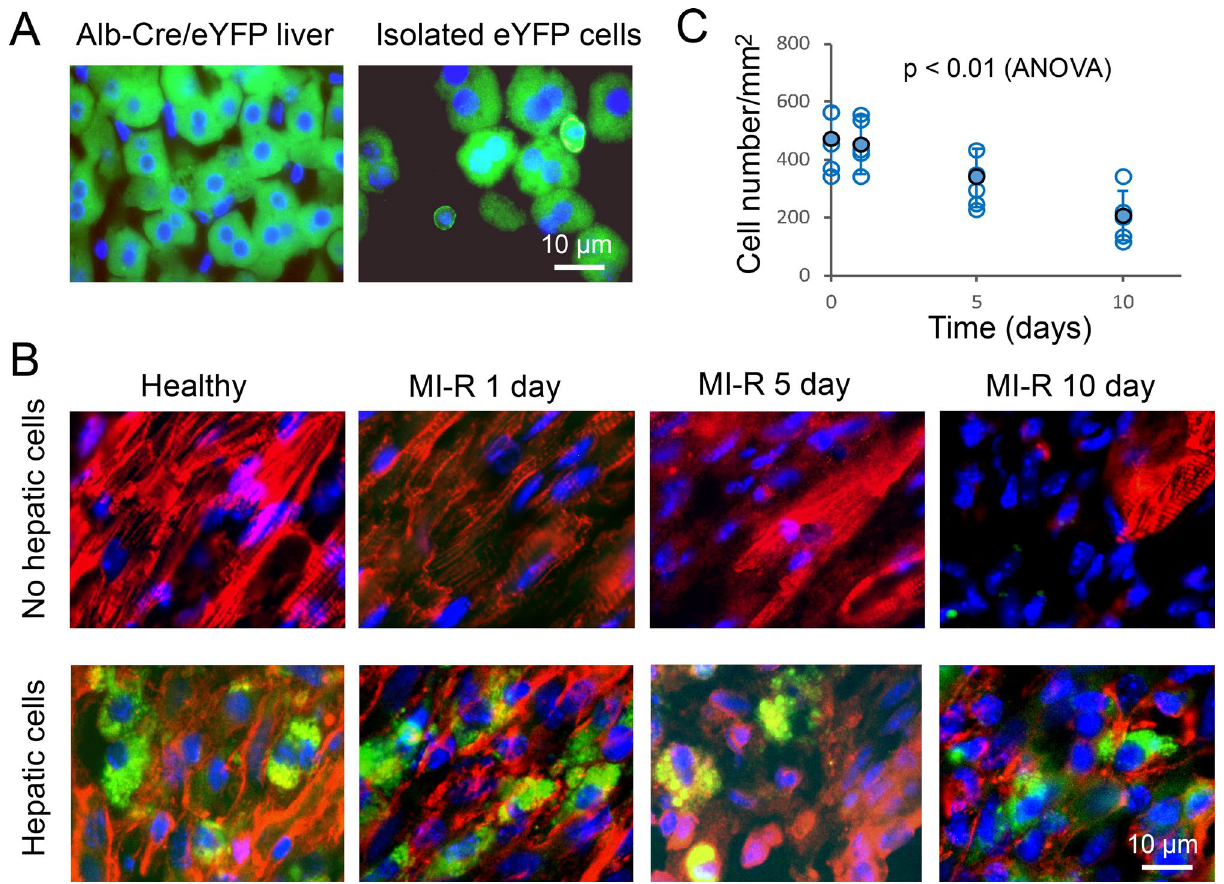
Figure 5. eYFP-positive hepatic cells transplanted to the myocardium of C57BL/6J mice with and without MI-R injury. ( A ) Fluorescence micrographs showing eYFP-positive hepatic cells (green) in the liver and isolated eYFP-positive hepatic cells in PBS placed on a microscope glass slide covered with a coverslip (note that almost all isolated hepatic cells were eYFP-positive). The length bar is for both images. ( B ) Fluorescence micrographs showing eYFP-positive hepatic cells (green) transplanted into the myocardium of a healthy mouse and into the ischemic myocardium core of mice with MI-R injury. Red: Antibody-labeled cardiac troponin I. Blue: Cell nuclei for both panels A and B. ( C ) Graphic representation of the density of eYFP-positive hepatic cells transplanted to the myocardium of C57BL/6J mice. Means and SDs are presented (n = 6). The solid and open circles represent the means and individual data